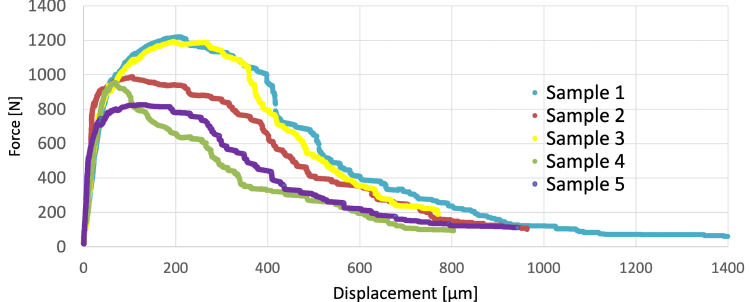
Figure 13. Force-displacement curves of medium sized